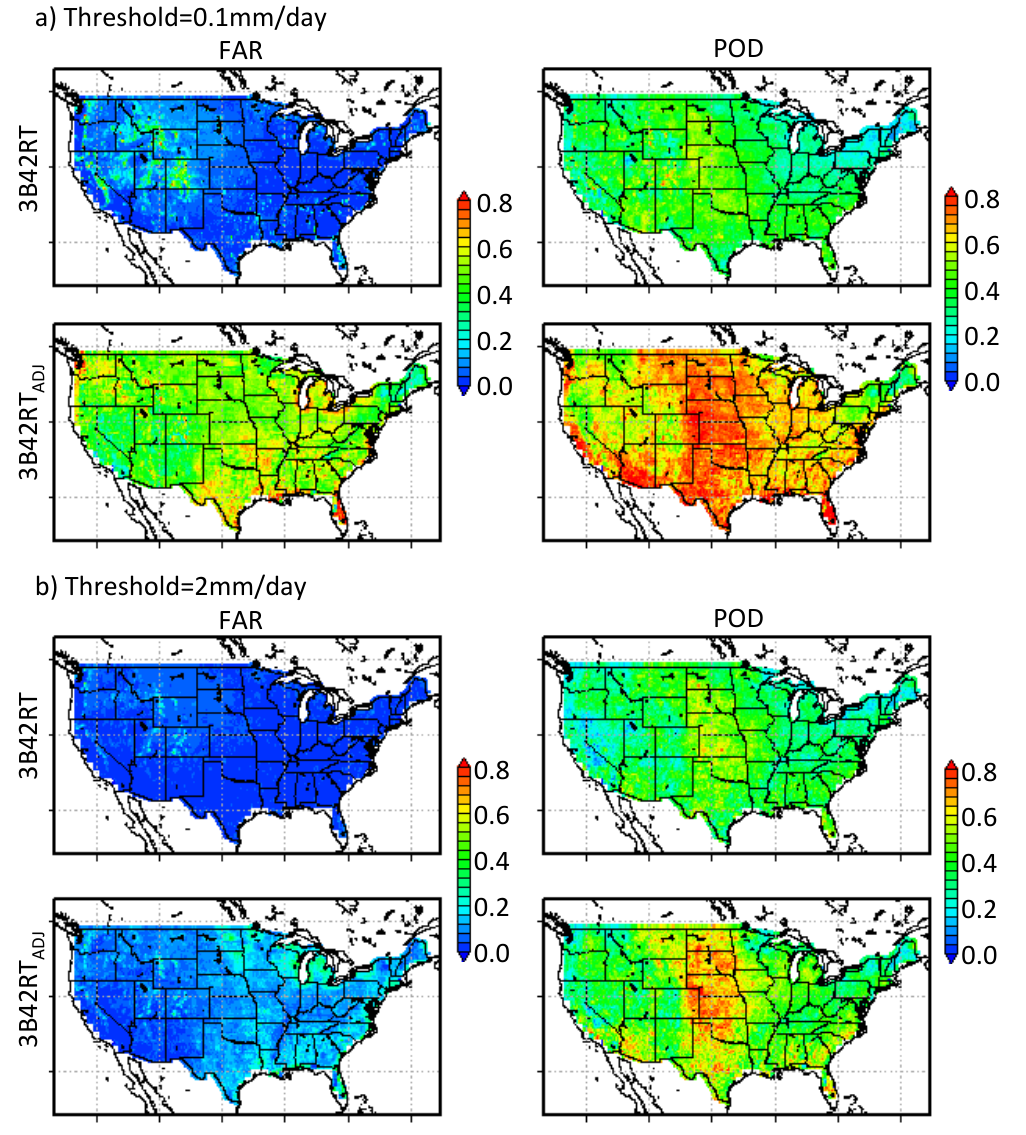
Figure 12. FAR and POD of 3B42RT (top panels) and 3B42RT ADJ (bottom panels) with (a) 0.1mmday − 1 and (b) 2mmday − 1 rainfall thresholds to define a rain